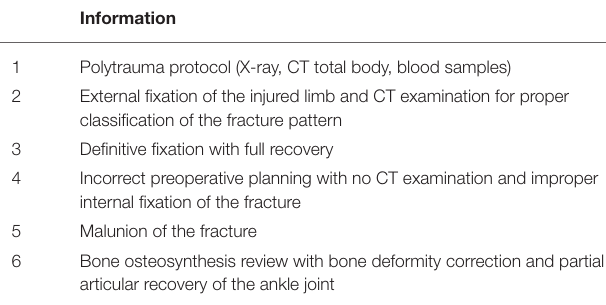
TABLE 2 | Information needed for the process of case study one. Information